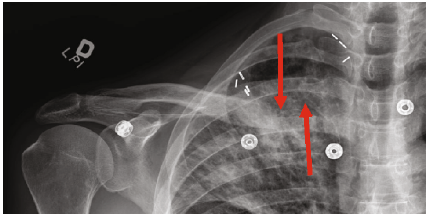
Figure 1: Clavicle radiograph fi ve months after the initial injury showing a right medial clavicle fracture nonunion (red arrows). Vascular clips are from a rib resection at a young